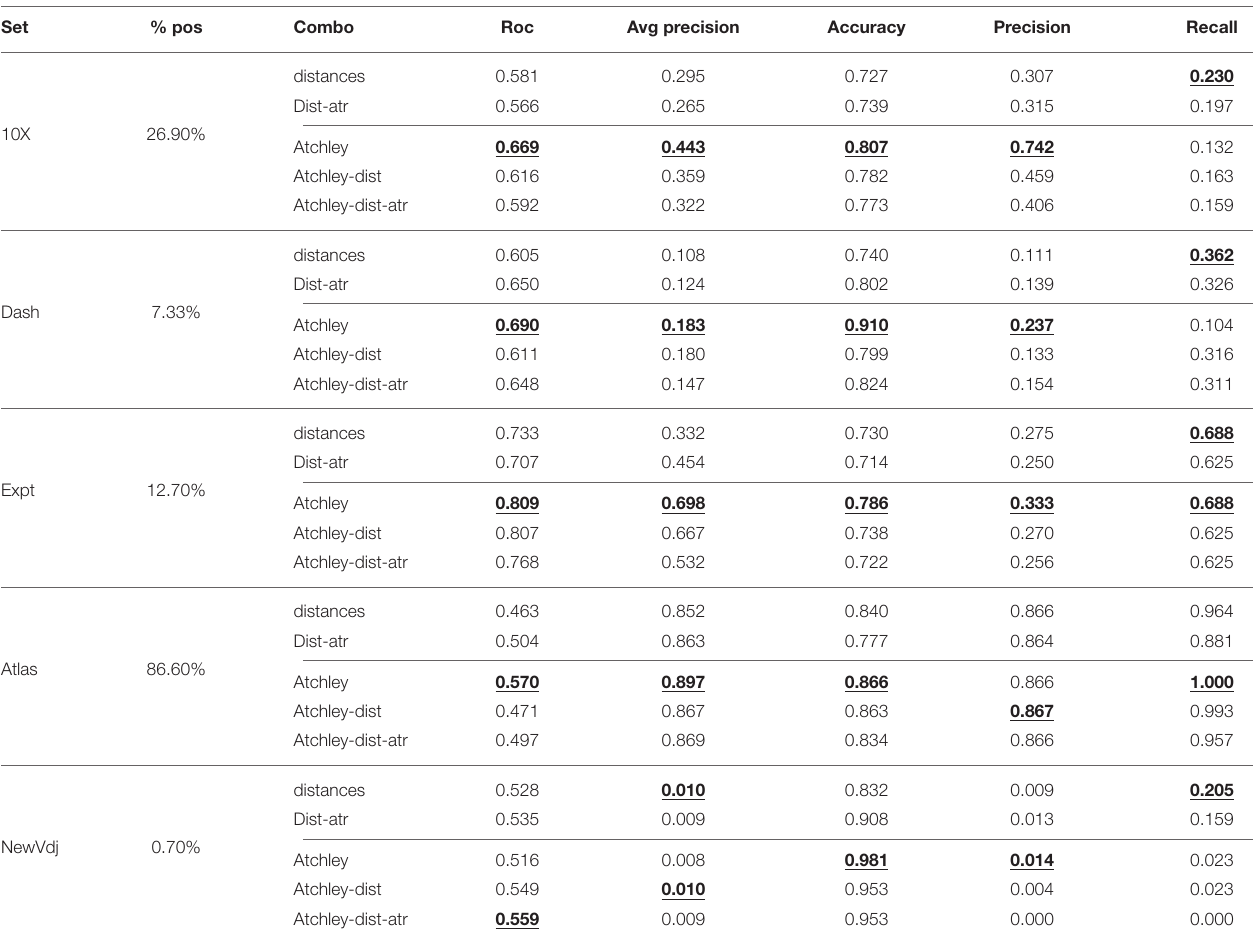
TABLE 2 | Results of out-of-sample